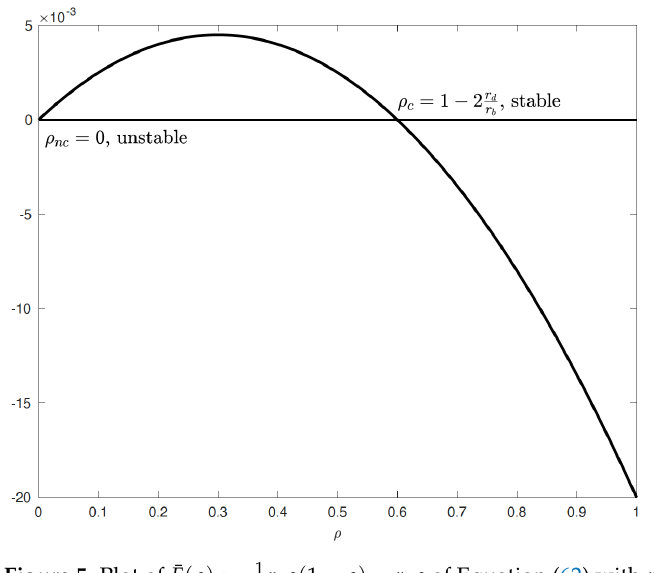
Figure 5. Plot of ¯ F ( ρ ) : = 1